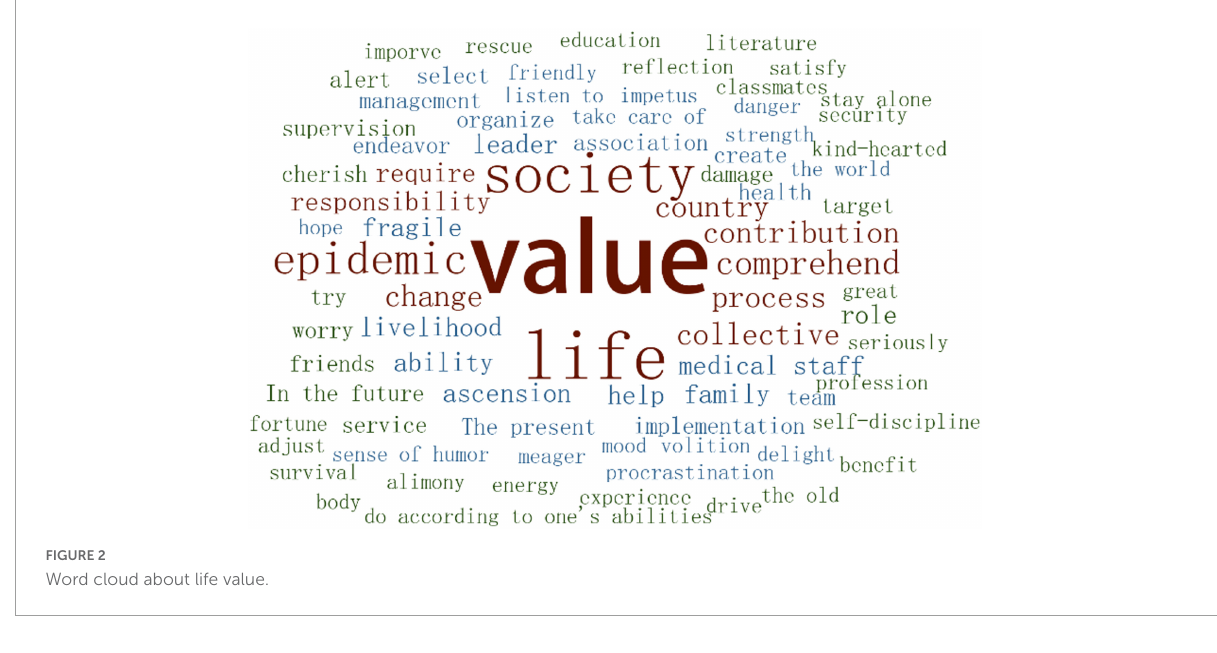
FIGURE2 Word cloud about life value.